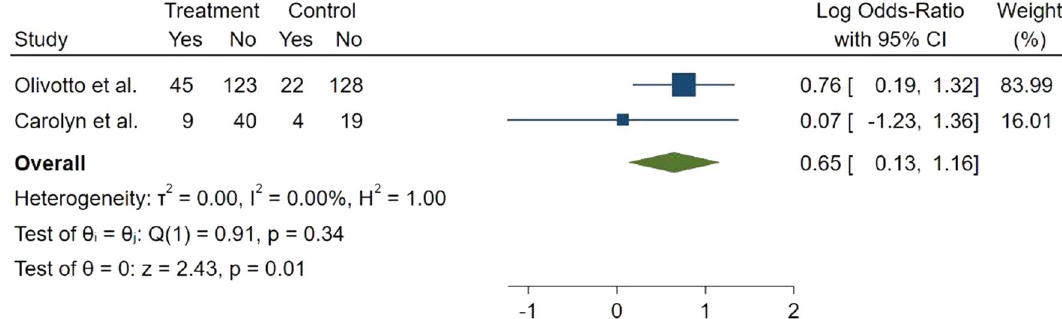
Fig. 4 Forest plot for clinical response